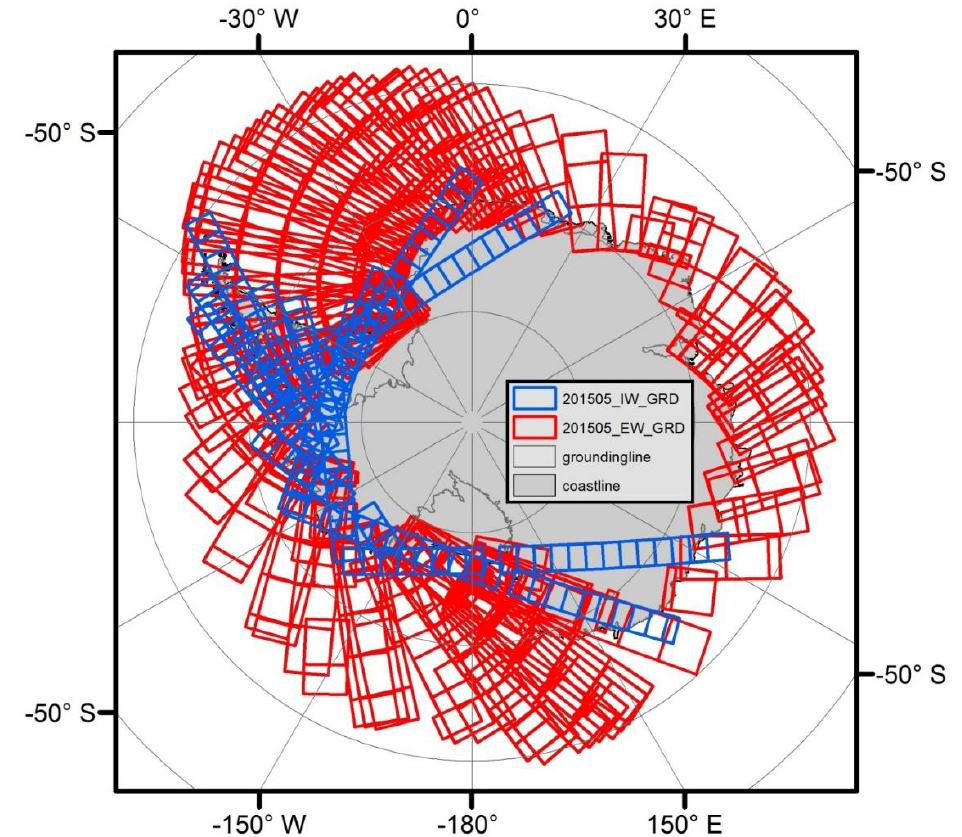
Figure 1. Spatial coverage of Sentinel-1A images from extra wide (EW) and interferometric wide (IW) around Antarctica during May 2015. The total number of images is 899, with 211 of IW images and 688 of EW images. Red and blue rectangles show footprints of EW and IW image respectively. A polar stereographic projection with −71°S as standard latitude is used.